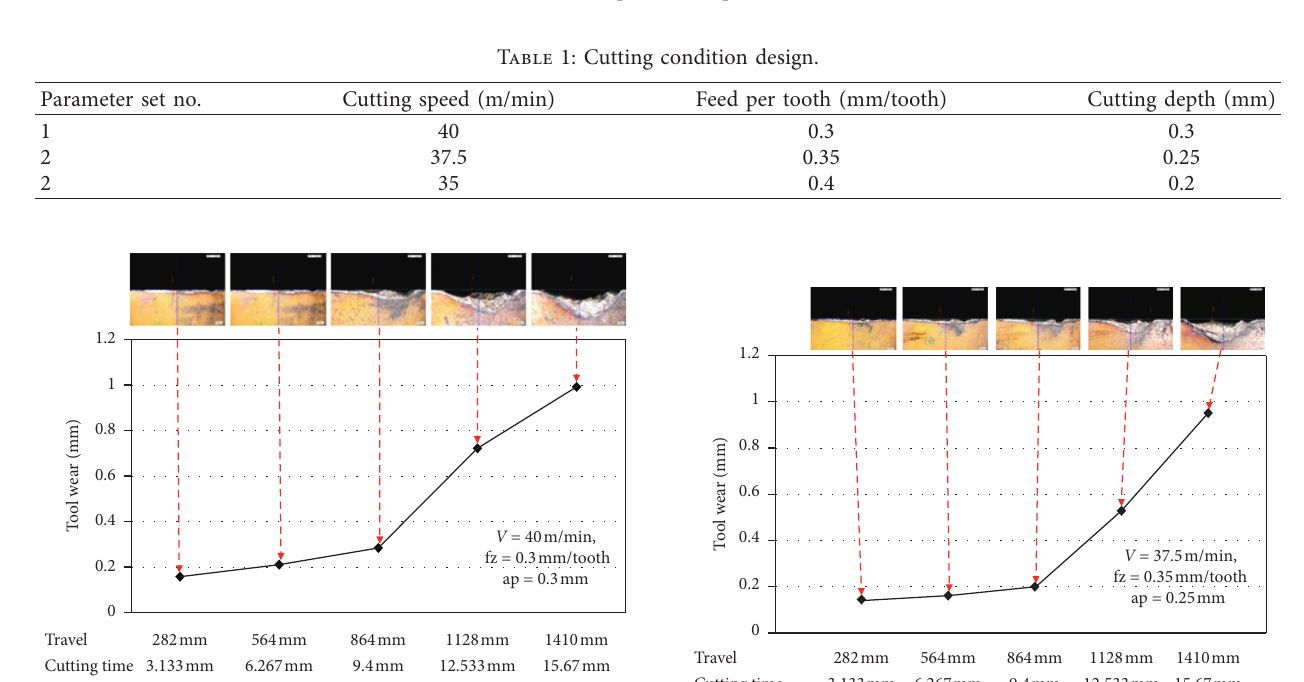
Figure 7: Tool wear under conditions of V � 40 m/min, fz � 0.3mm/tooth, and ap � 0.3mm.